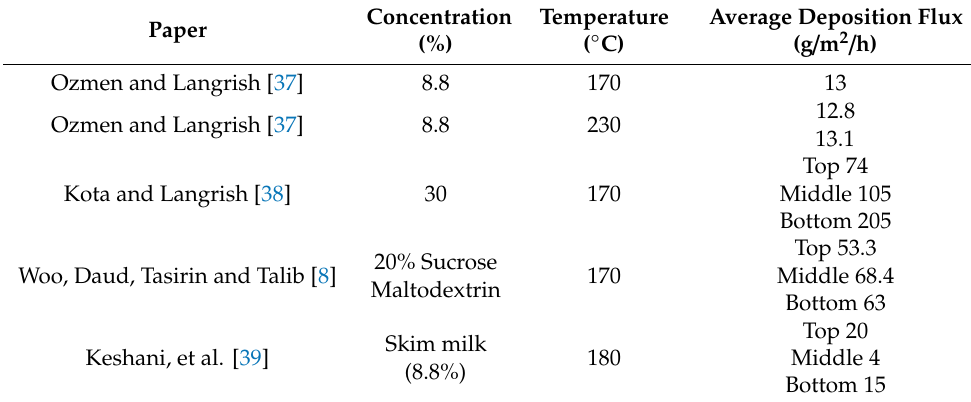
Table 8. Literature wall fluxes in spray dryers for an inlet gas temperature of 170 ◦ C and an 8.8% skim milk powder